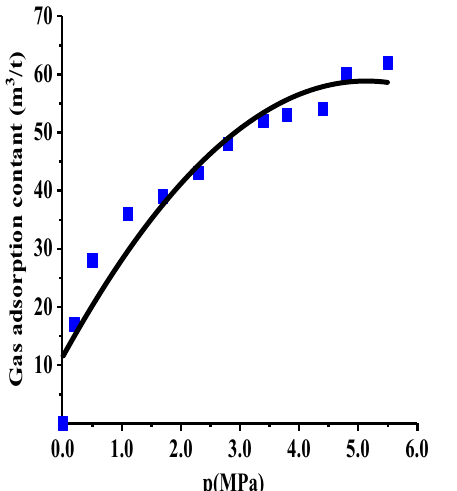
Table 5 Gas adsorption constant, industrial analysis of No. 5, 6 and